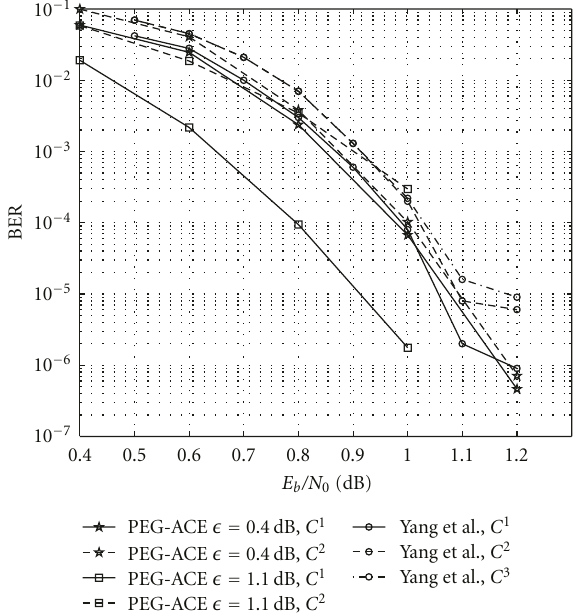
Figure 7: BER performance of two PEG-ACE codes with n = 8192 and d v max = 30 and the code designed by Yang et al . [7] with n = 10000 and d v max =